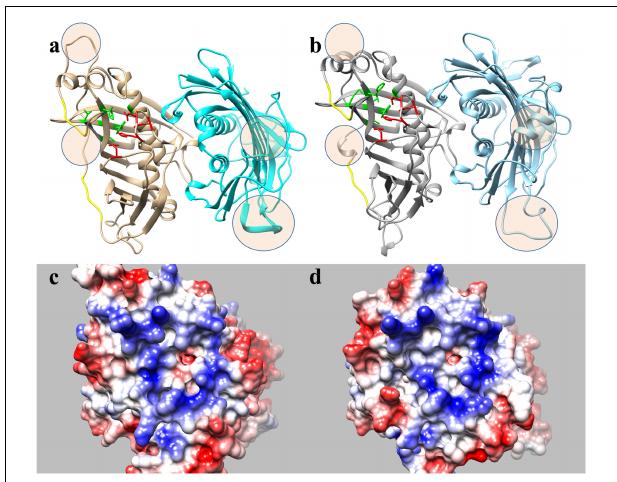
FIGURE 4 | Proposed structural models for sunflower acyl-ACP thioesterase homodimers, Ha FatA (a,c) and Ha FatB (b,d) , modeled from UcFatB (5X04.A) (Feng et al., 2017). Ribbon diagrams (a,b) , residues in the substrate binding pocket are green and those involved in catalysis are in red. In c,d , the molecular surfaces show the electrostatic potential according to Coulomb’s laws with positive charged patches surrounding the substrate binding pocket. Circled areas in a,b correspond to highly no conserved structural motifs between both proteins.